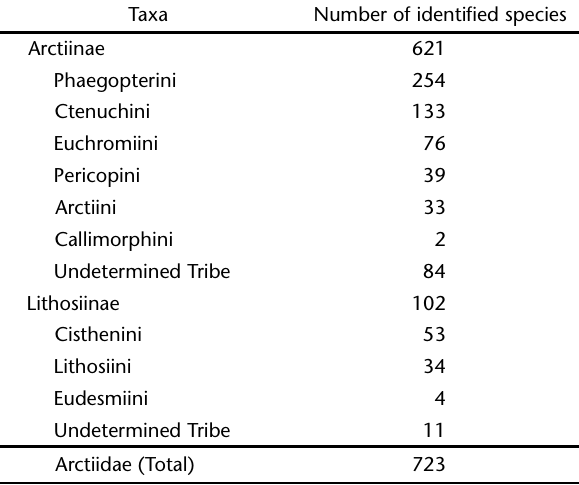
Table I. Number of species of tiger moth subfamilies and tribes occurring in the Cerrado region. Taxa Number of identified species Arctiinae 621